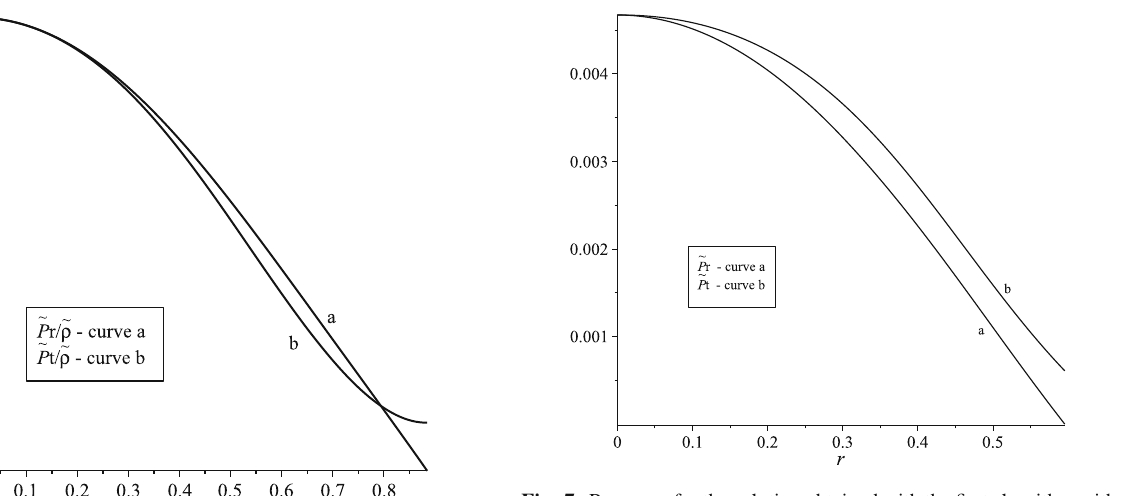
Fig. 7 Pressures for the solution obtained with the first algorithm with F (cid:9)= 0 from the isotropic Gold III solution